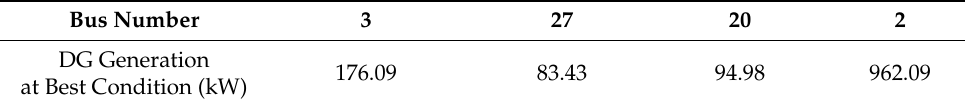
Table 3. Results of the first stage (placement and sizing of RES units results).